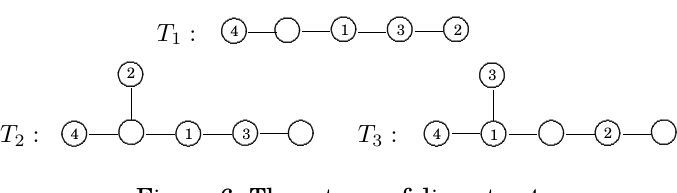
Figure 6: Three trees of diameter 4